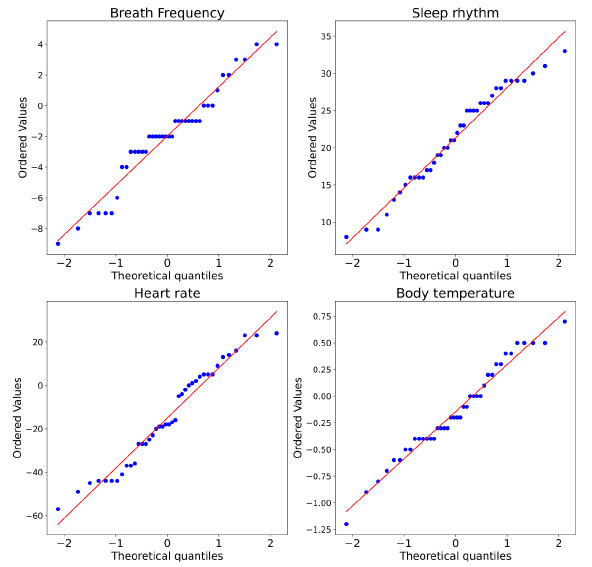
Figure 12. Q–Q plot of measurements captured for two conditions: without and with sensors. Table 9. Normality test and corresponding paired test to use.